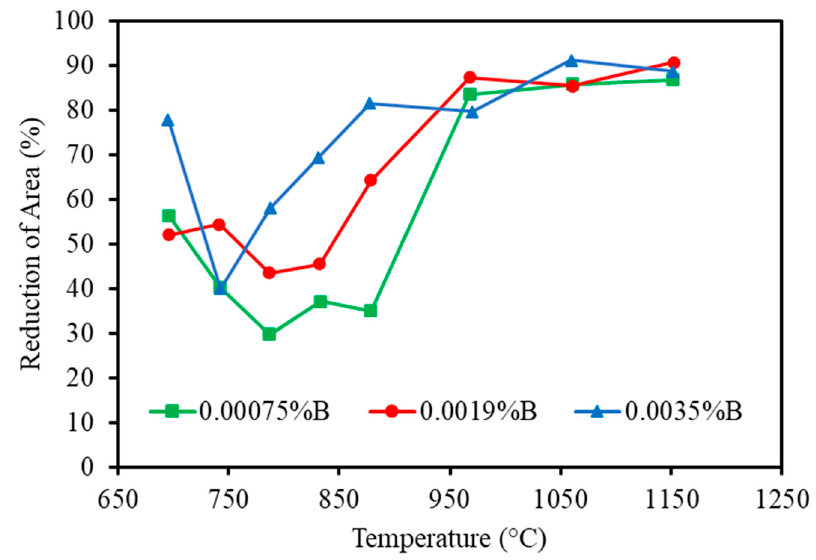
Figure 7. Hot ductility curves for specimens doped with different quantities of boron. The base composition of steel was 0.12% C, 0.25% Si, 0.5% Mn, 0.15% Al, 2.3% Cr, and 0.95% Mo [31]. Adapted from [31], with permission from Elsevier, 2023.